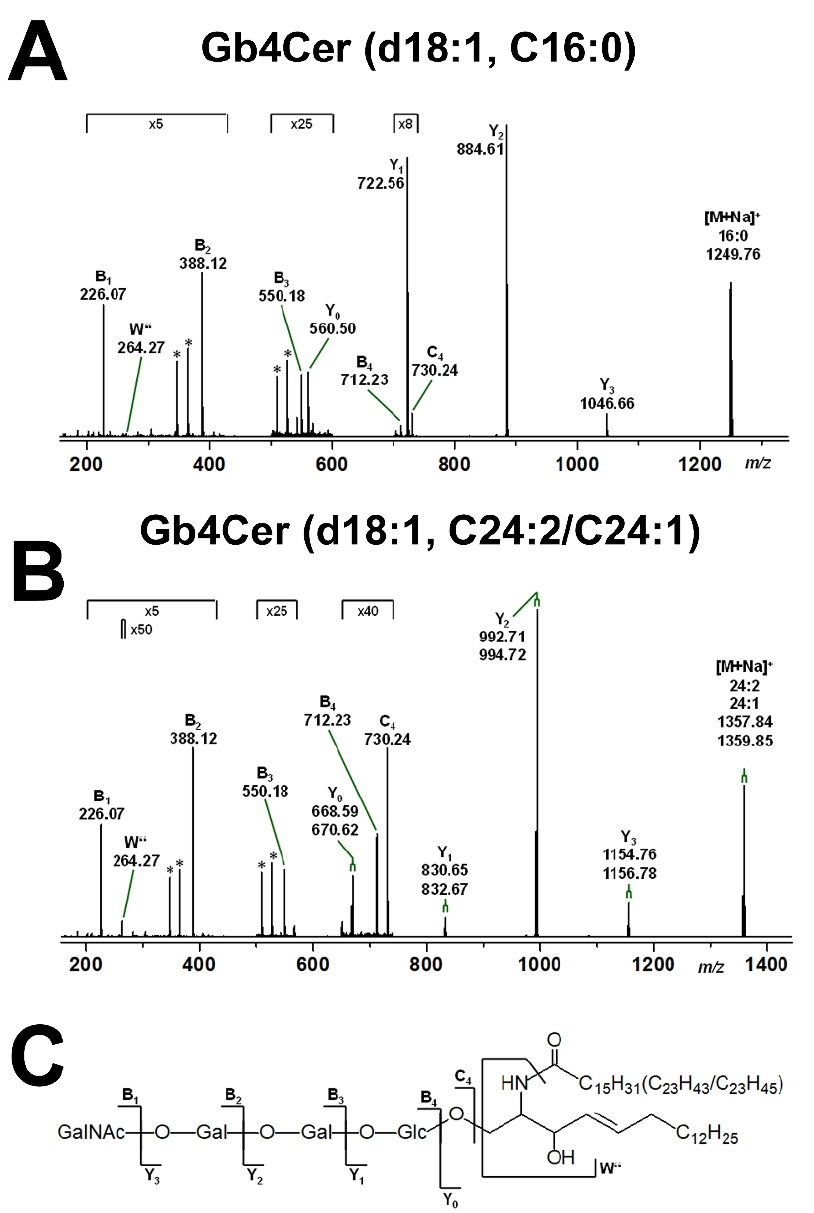
Figure 4. MS 2 spectrum of selected Gb4Cer (d18:1, C16:0) ( A ) and Gb4Cer (d18:1, C24:2/C24:1) ( B ) obtained from serum-free cultivated pHCoEpiCs and the explanatory fragmentation scheme ( C ). The MS 2 spectra were obtained from a GSL preparation of replicate 1 (R1; see Figure 1) using the positive ion mode. [M+Na] + adducts of the various Gb4Cer lipoforms harboring sphingosine (d18:1) and variable fatty acids as indicated were fragmented by means of collision-induced dissociation (CID). The asterisks mark internal fragments. Table 1. Stx receptor GSLs of serum-free cultivated pHCoEpiCs determined by mass spectrometry combined with TLC immunodetection 1 .